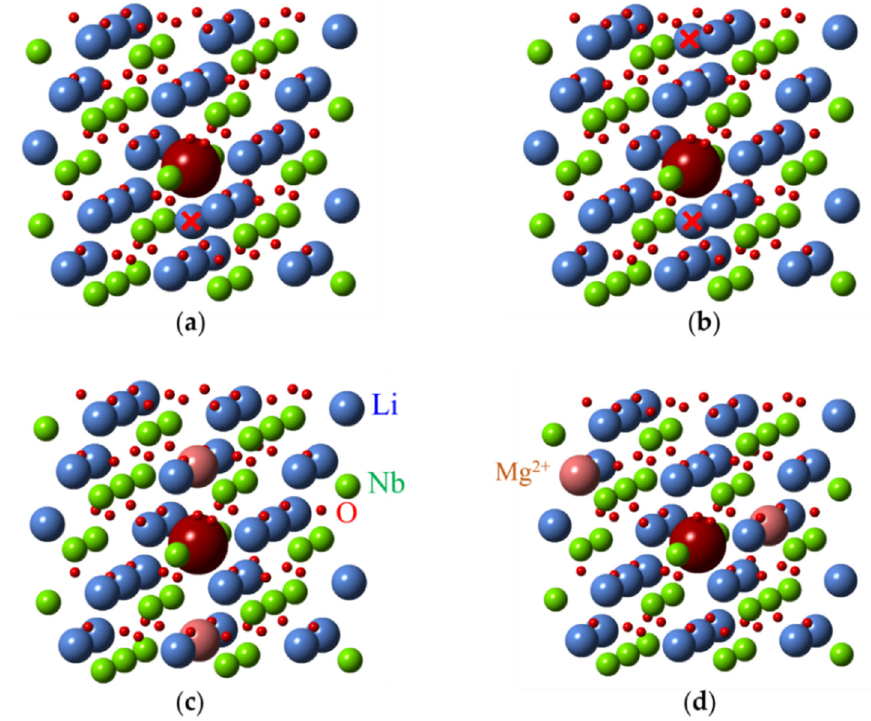
Figure 19. Possible structures of Me 3+Nb5+ (large magenta ball) centers in LN. Structure with one ( a ) and two ( b ) additional Li ions in v oct (marked with red crosses). Axial ( c ) and low-symmetry ( d ) structures with two Mg 2+Li+ ions.